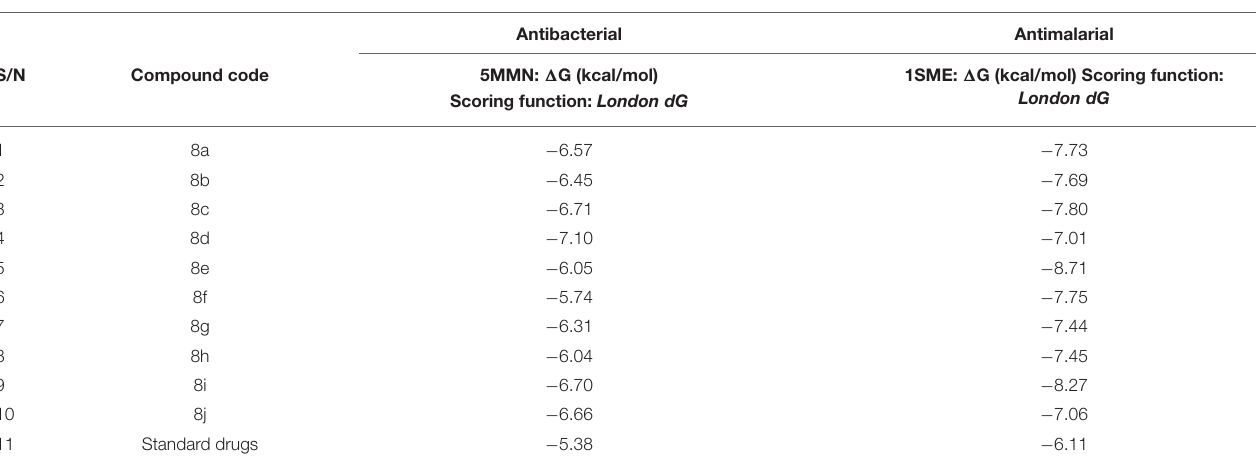
1SME: 1 G (kcal/mol) Scoring function: London